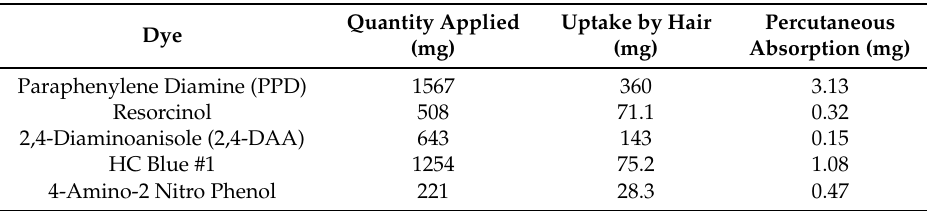
Table 1. Uptake of dyes by hair and skin.